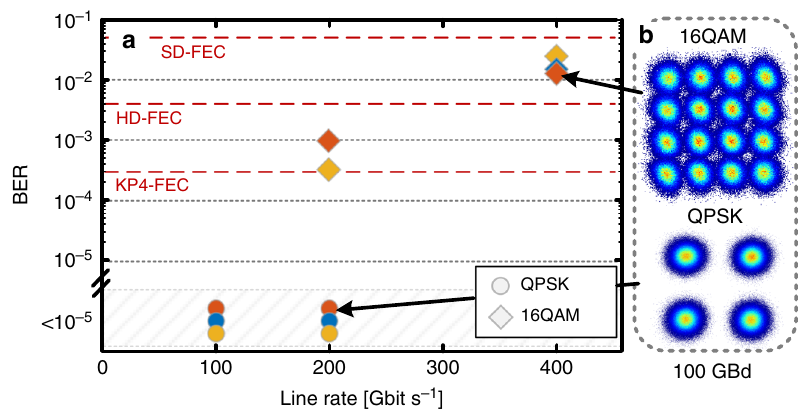
Fig. 2 Results of the high-speed data modulation experiments. a BER as a function of the line rate for three devices, IQ1-3 (blue, red, and yellow). QPSK: circles, 16QAM: diamonds. Operation well below the KP4 FEC threshold for all QPSK measurements. Operation below the 7% HD-FEC threshold at 50 GBd 16QAM and the SD-FEC limit 100 GBd 16QAM. Measurements with BERs below 1×10 − 5 are grouped. b Constellation diagrams for 100 GBd 16QAM and QPSK